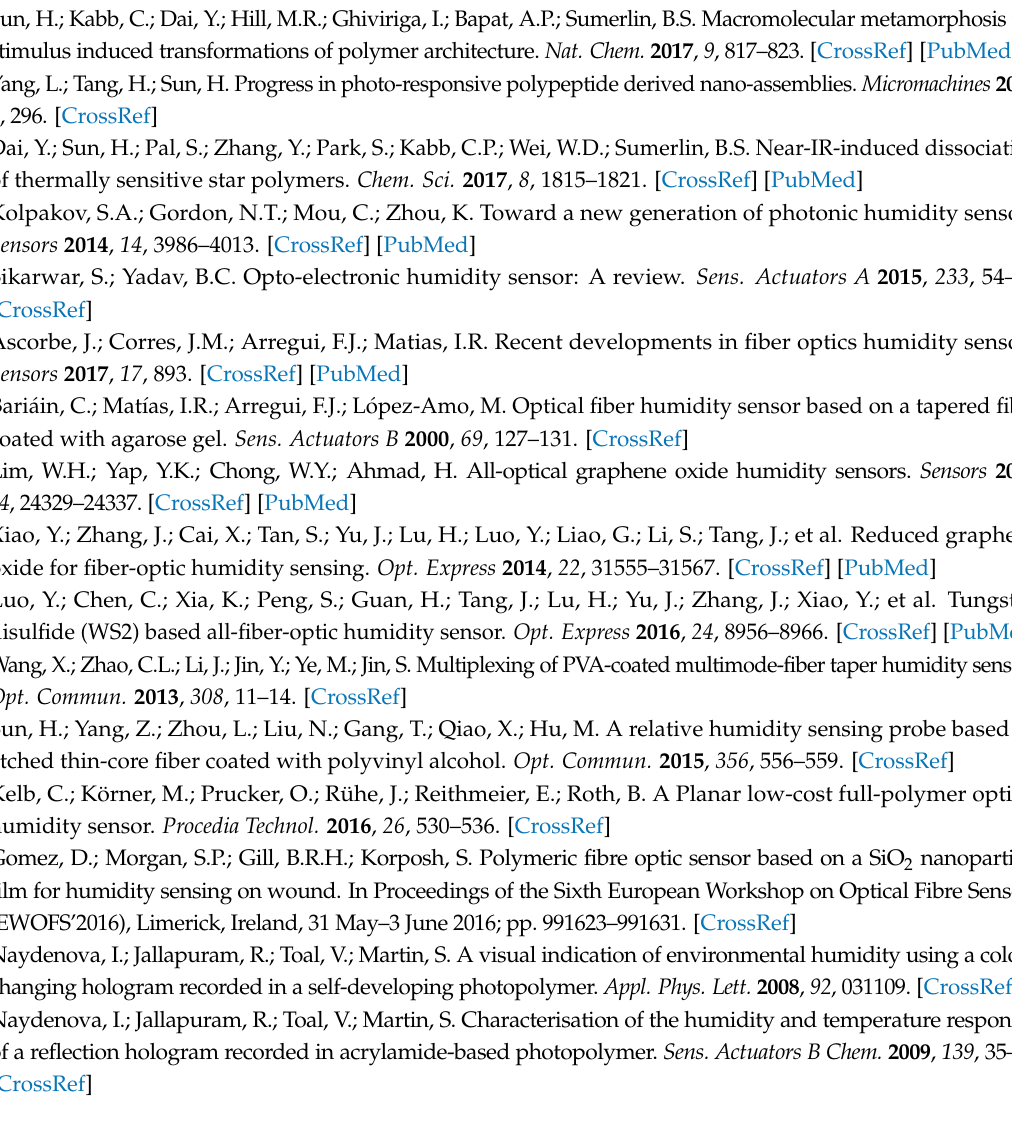
Figure S1: Overlaid 1 H NMR spectra (600 MHz; solvent D 2 O) of copolymers P1–P4; Figure S2: Overlaid SEC traces of linear copolymer P1 and branched copolymer P4; Figure S3: Zimm diagrams for copolymers P1 (left) and P4